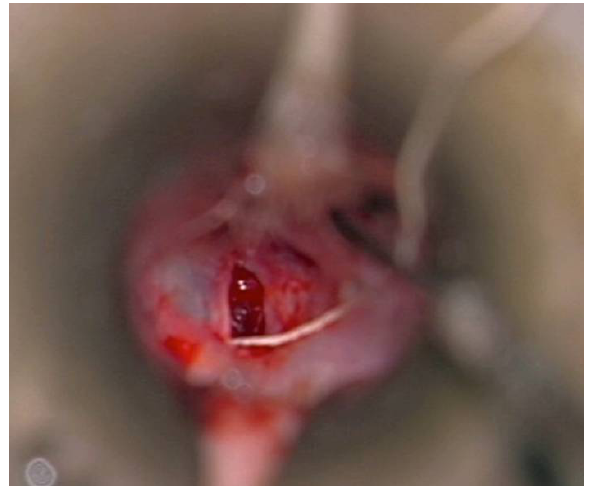
Figure 1. Cotton-wick electrode placed on the round window.